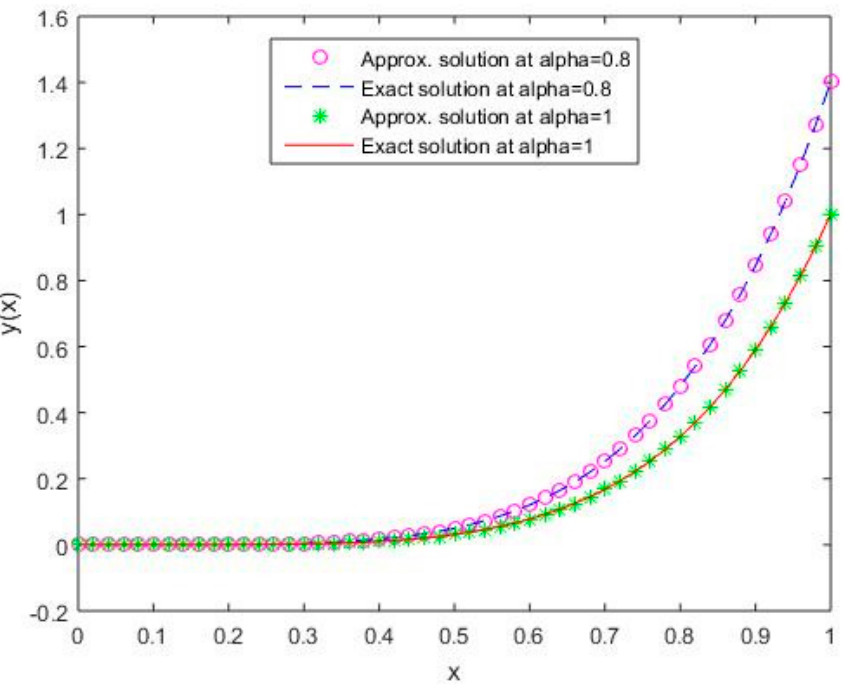
Figure 1. Comparison of exact and numerical solutions using S1 for 𝛼 = 0.8 and 𝛼 = 1 , Example 1.